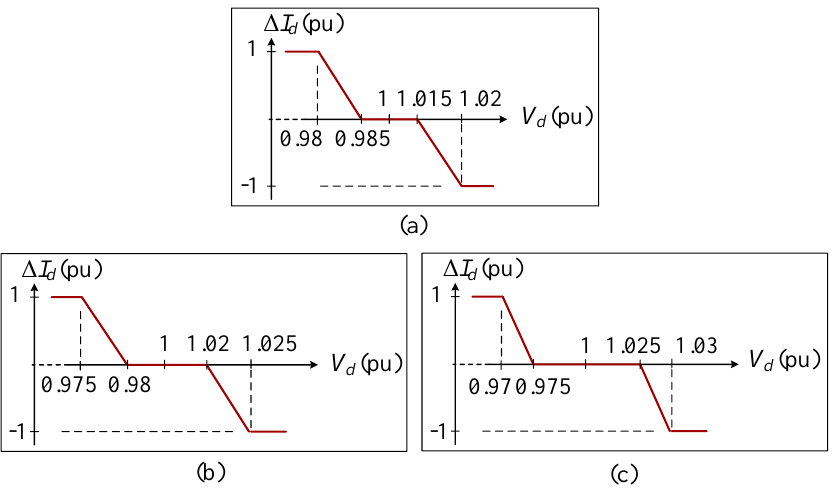
Figure 4. I d -V d droop control for the modular configuration of the grid-interfacing converters ( a ) for MGSC-1, ( b ) for MGSC-2 and ( c ) for MGSC-3 (see Figure 1).